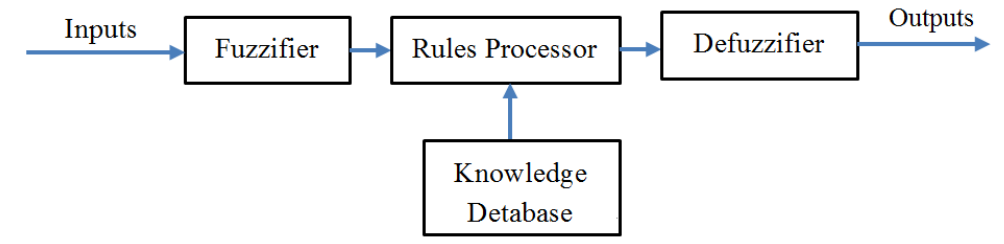
Figure 9. The structure of a fuzzy logic system.